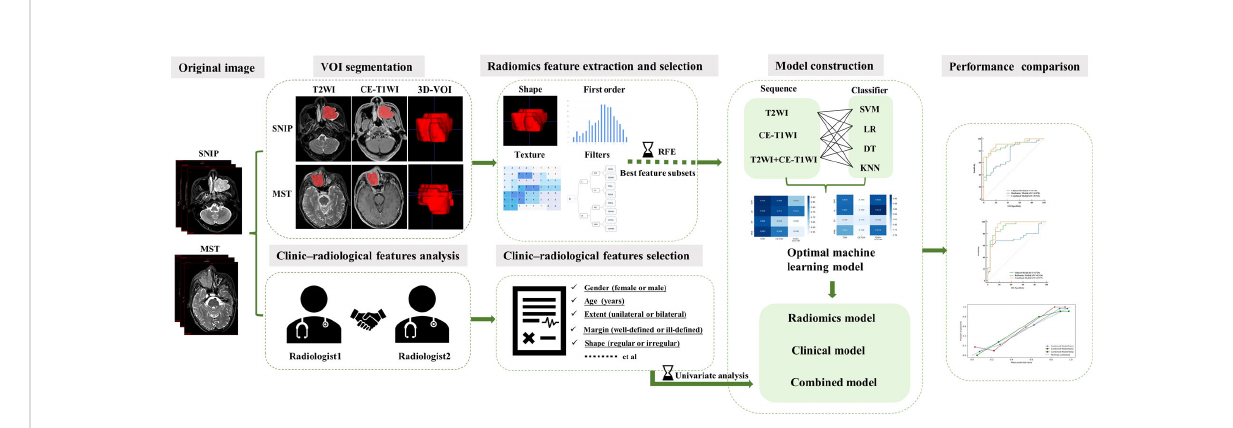
FIGURE 1 The research work fl ow of the whole study. SNIP, sinonasal inverted papilloma; MST, malignant sinonasal tumor; 3D-VOI, three-dimensional volume of interest; SVM, support vector machine; LR, logistic regression; DT, decision tree; KNN, k-nearest